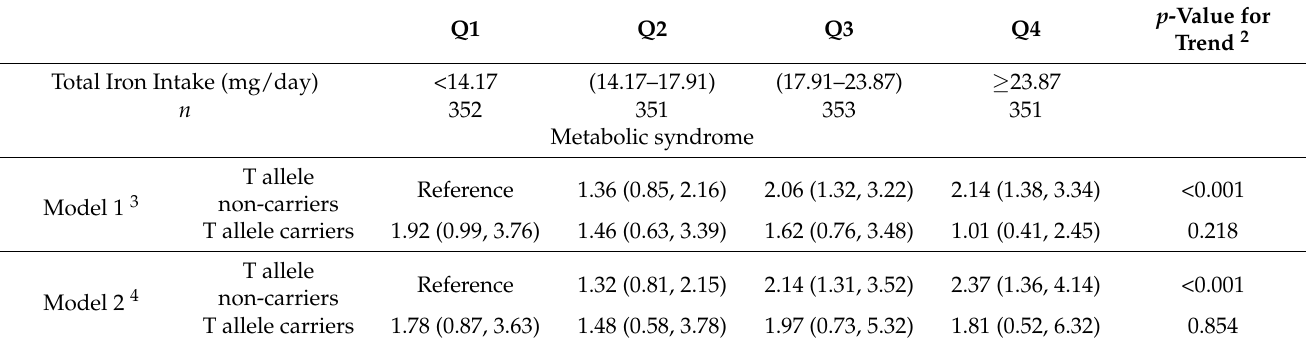
Table 5. ORs (95% CI) for MetS and its components according to the quartiles of total dietary iron intake among the male participants stratified by T allele presence of rs516946 1